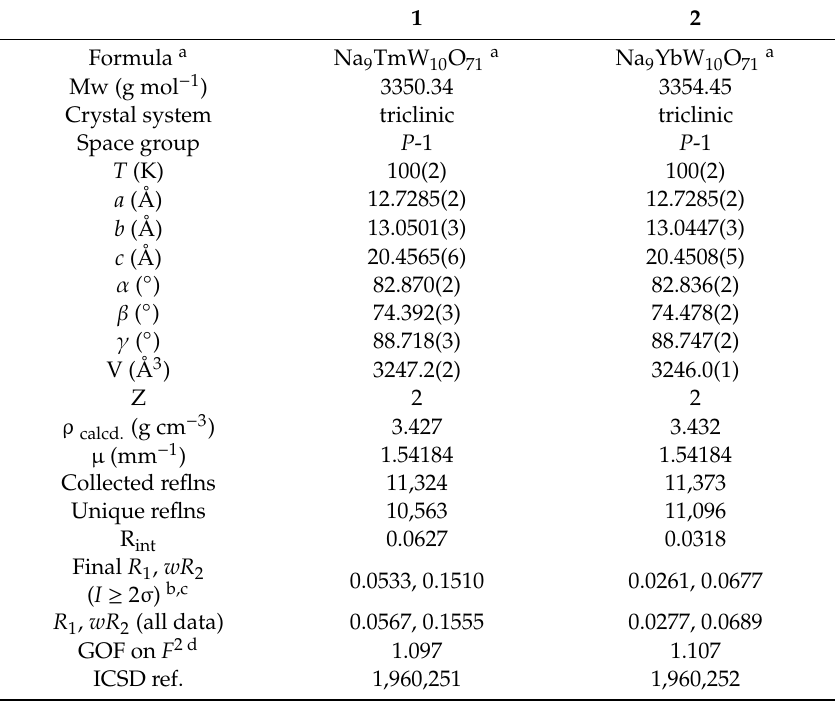
Table 1. Selected crystallographic data and refinement parameters of 1 and 2 .